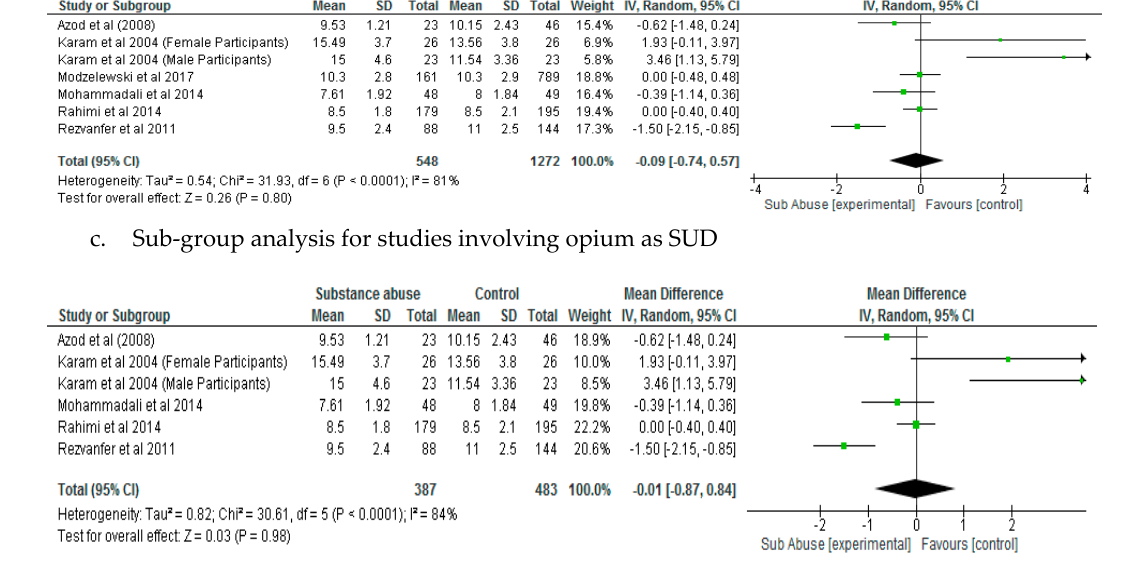
Figure 6. Results of Glycated Haemoglobin (%).